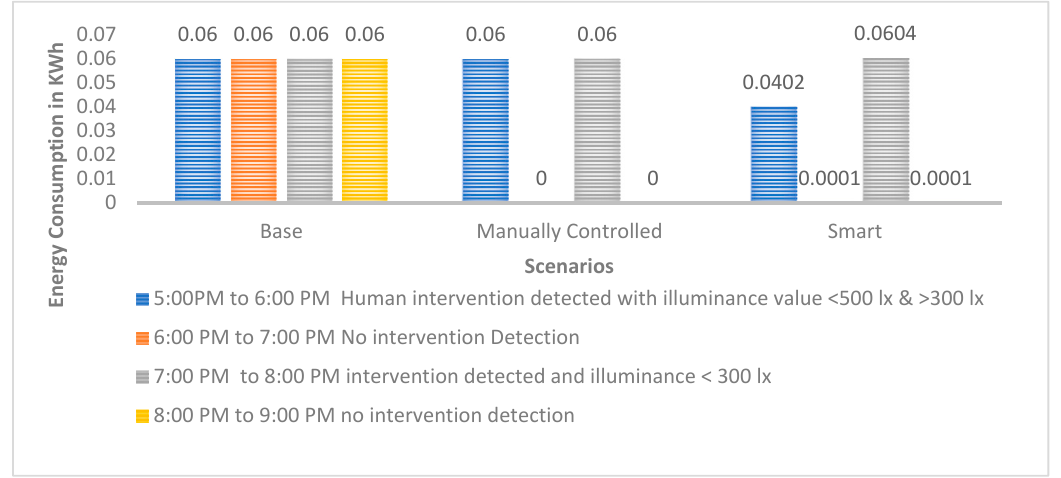
Figure 5. Graph for energy consumption of a 60 W incandescent light bulb in three scenarios.